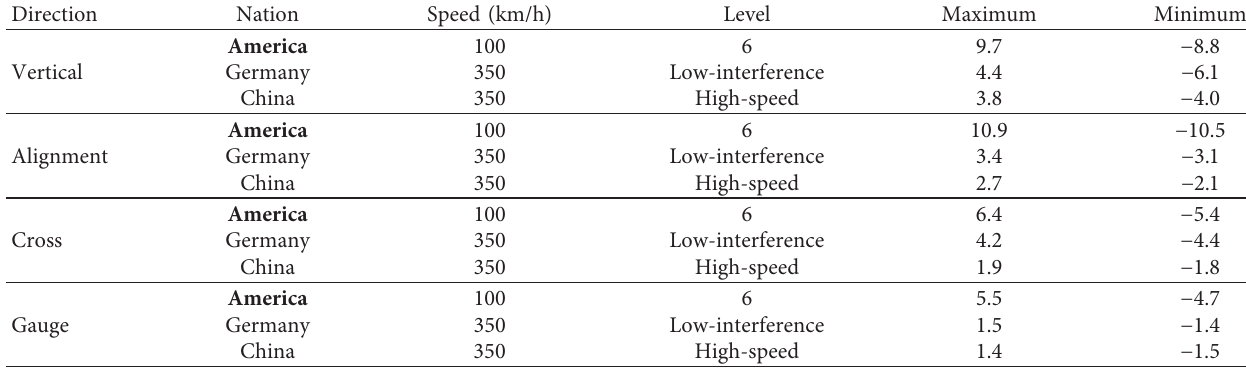
Table 1: The maximum and minimum displacements of irregularity (unit: mm).